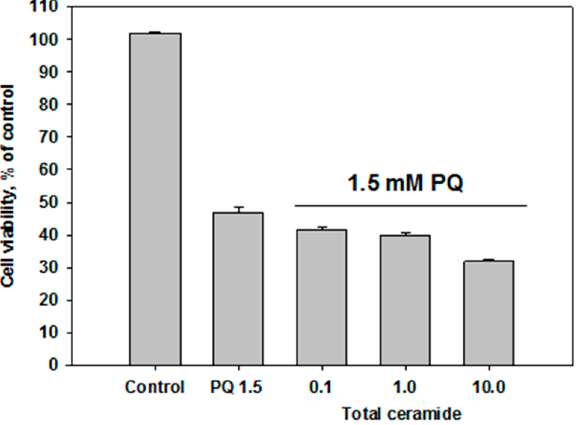
Figure 7. E ff ect of total ceramide on neurotoxicity of paraquat (PQ): the impact of 1 h pre-incubation with phytoceramides on the viability of Neuro-2a cells.